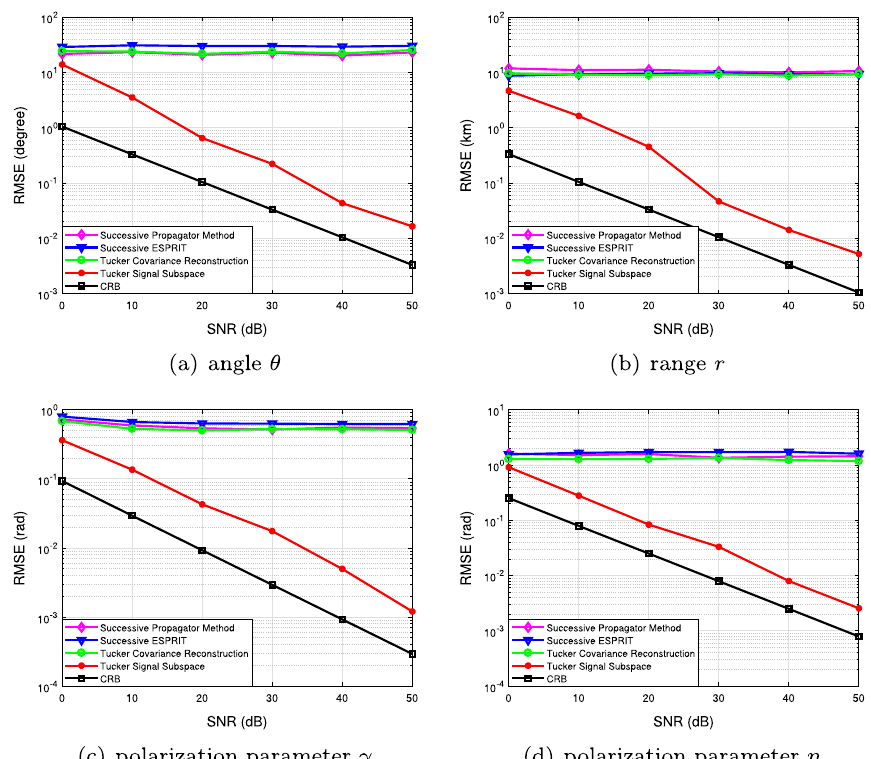
Fig. 6 RMSE versus SNR for range, angle and polarization estimation with a single snapshot. M = 6 , N = 6 , P = 3 , L = 1 and 100 independent trials. (θ , r ) = ( 40 ◦ ,4km ) , ( − 30 ◦ ,2km ) , ( 10 ◦ ,5km ) and (γ , η) = (π/ 10, π/ 5 )(π/ 5,3 π/ 5 )(π/ 4,2 π/ 5